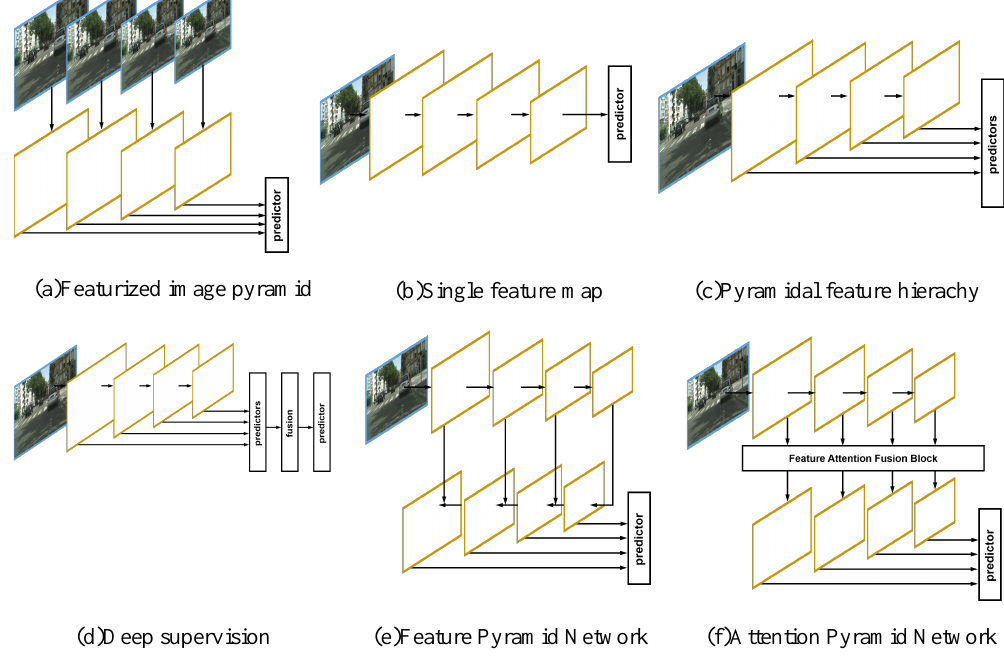
Figure 1. Different architectures for addressing multiple scales and sizes where feature maps are indicated by yellow